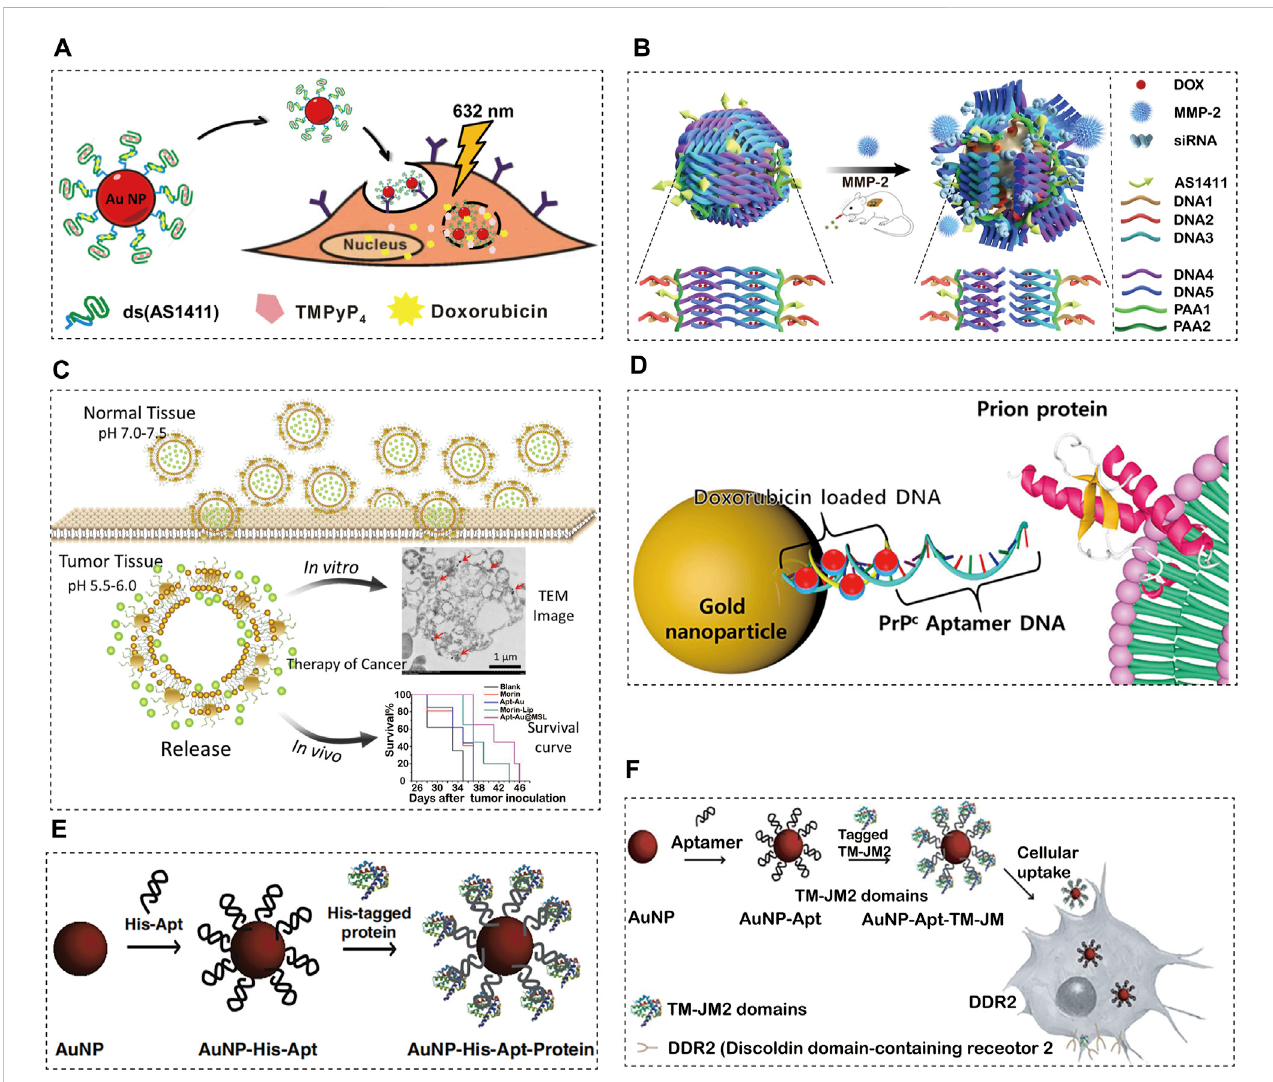
FIGURE 3 Aptamer-conjugated AuNPs for cancer therapeutics. (A) Schematic Illustration of the Co-Drug-Loaded Aptamer-Functionalized Delivery Platform on the Basis of Gold Nanoparticles, reprinted with permission from(Lopes-Nunes et al., 2021), Copyright 2014, American Cemical Society; (B) The schematic illustration of the construction of gold nanocages and the tumour-induced gene- and DOX-releasing mechanism, reprinted with permission from(Yang Y et al., 2021), Copyright 2021, Spinger Nature; (C) Proposed schematic diagram of designed Apt-Au@MSL containing Morin for drug delivery to cancer cells with tumour-targeted property, reprinted with permission from(Ding et al., 2020), Copyright 2020, Nanoscale Research Letters; (D) Synthesis